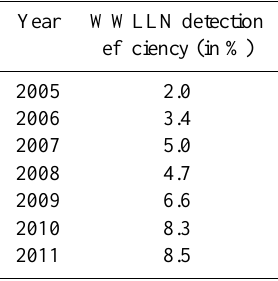
Table 1. WWLLN detection efficiency obtained using the LIS/OTD data as ground